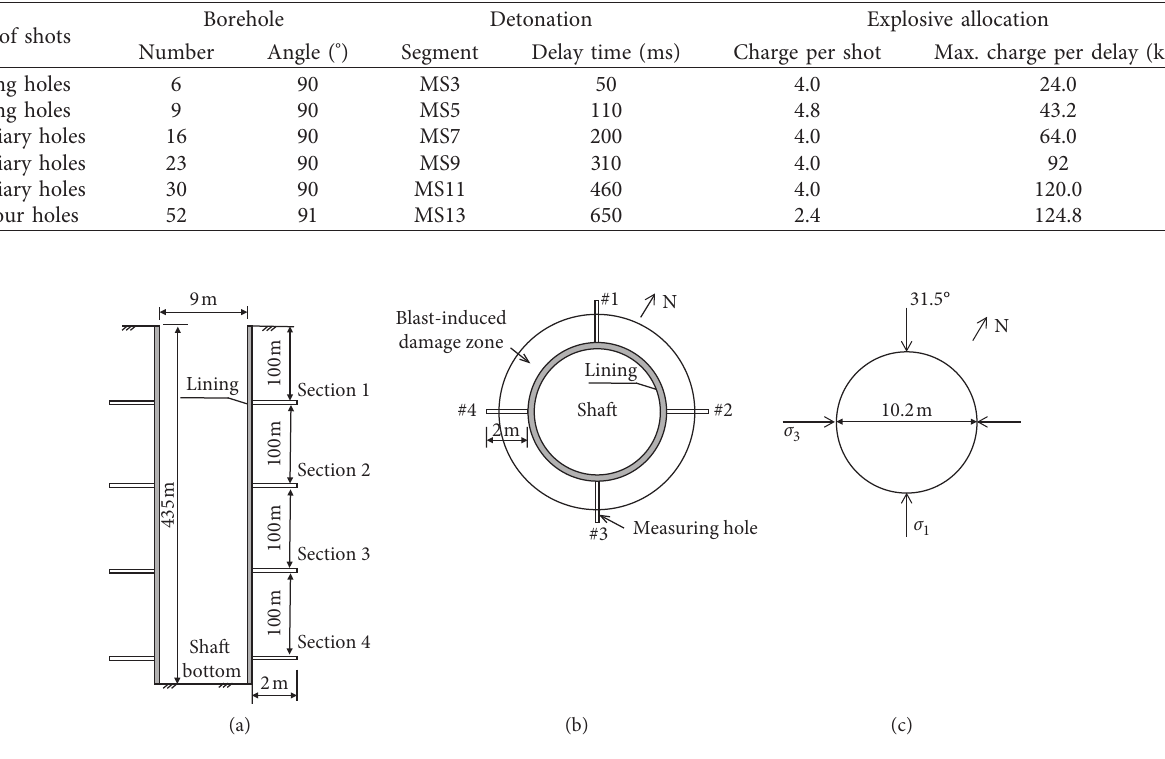
Table 2: Blasting parameters.